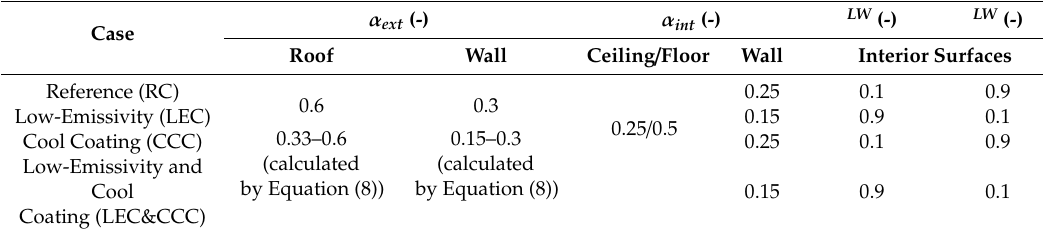
Table 3. Case study: radiative